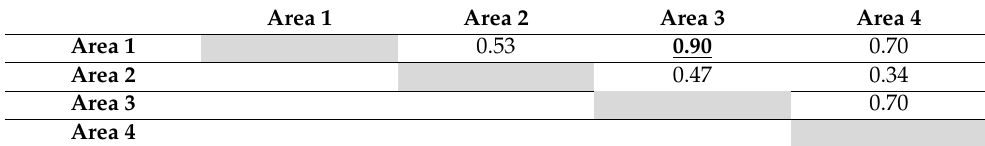
Table 6. Linear correlation coefficient of the four areas using the TCG